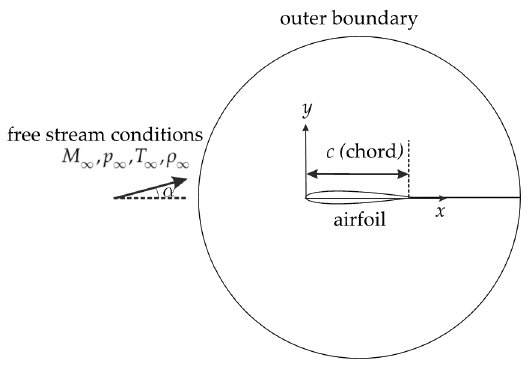
Figure 1. Flow domain and free stream conditions.